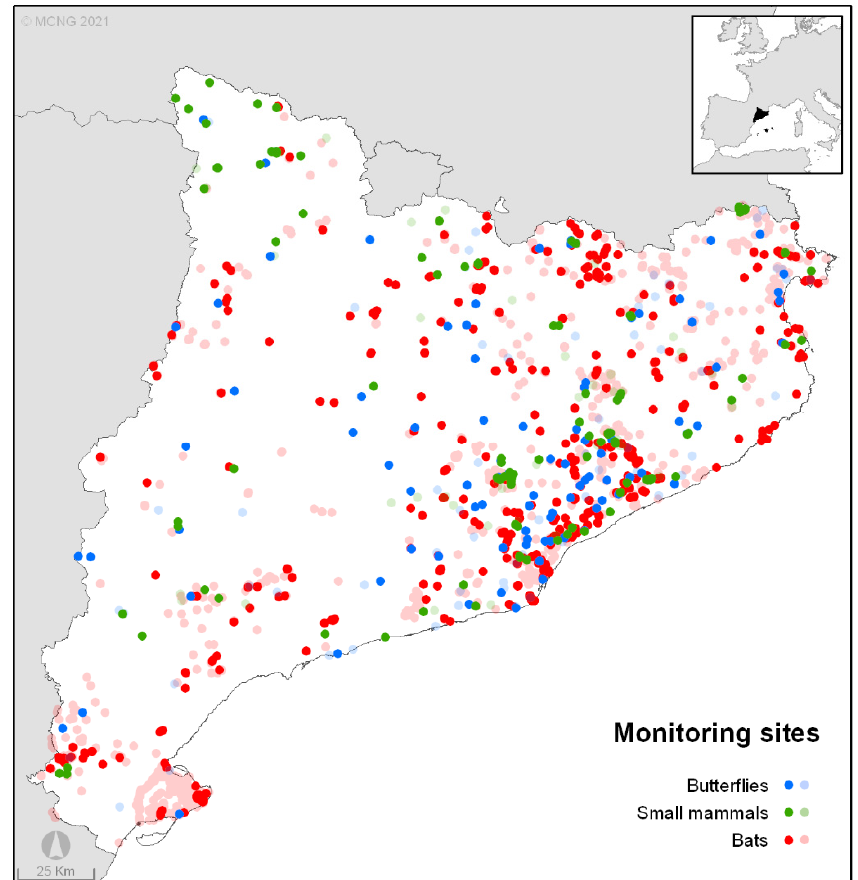
Figure 1. Sampling stations for the three main taxa monitored by MCNG during 2020 (solid colours) and historical (light colours) in Catalonia (NE Spain).